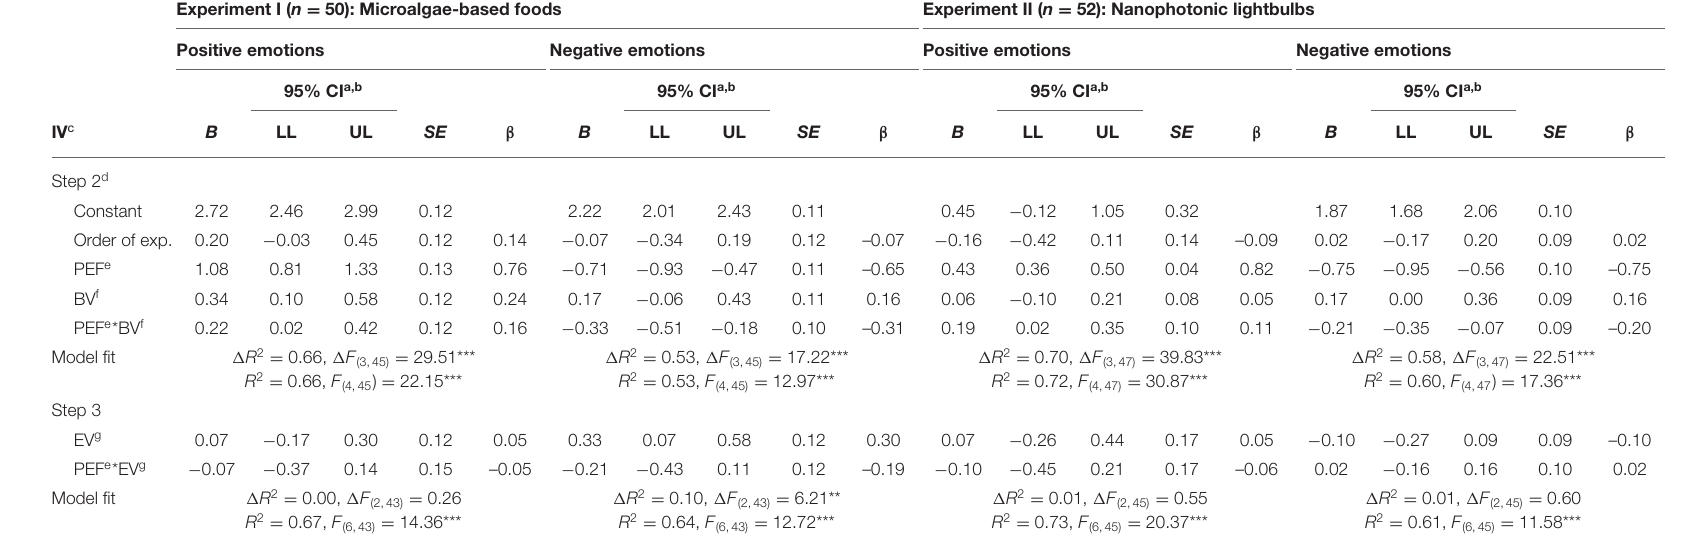
TABLE 2 | Regression coefficients of innovations’ perceived environmental friendliness, values, and their interactions on positive and negative emotions toward the innovations. Experiment I ( n = 50): Microalgae-based foods Experiment II ( n = 52): Nanophotonic